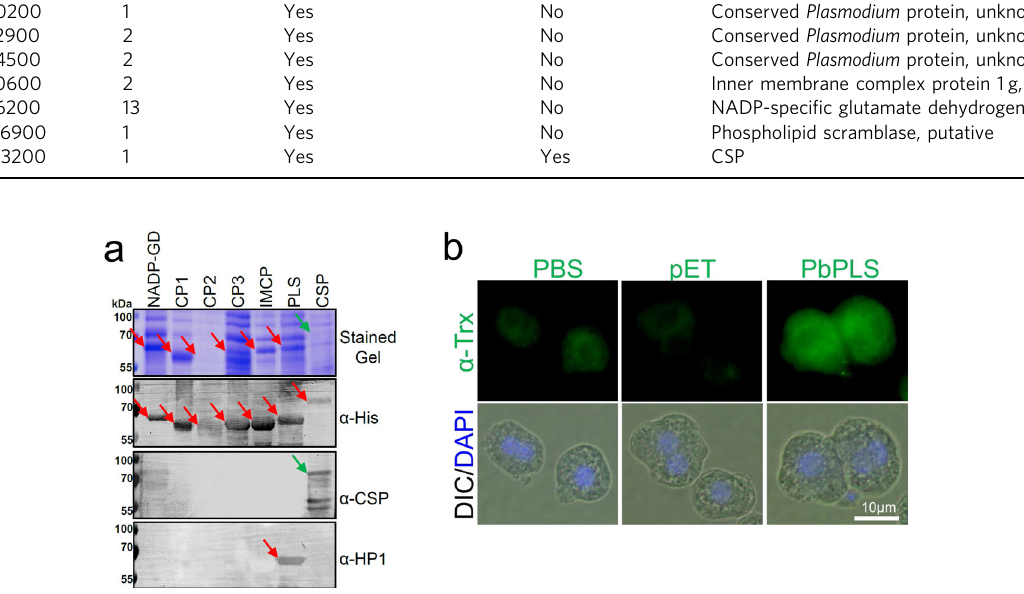
Table 1 Mass spectroscopy analysis of a gel piece (red box in Fig. 4a) identi fi ed seven sporozoite surface proteins. PlasmoDB ID